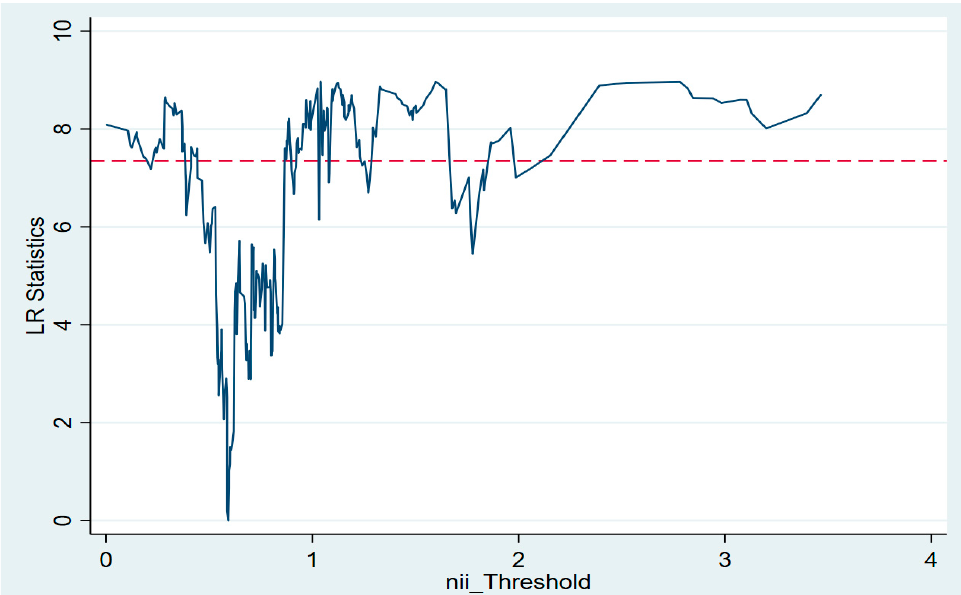
Figure 3. Non-interest income threshold value. Table 11. The impact of non-interest income on the performance of commercial banks corresponds